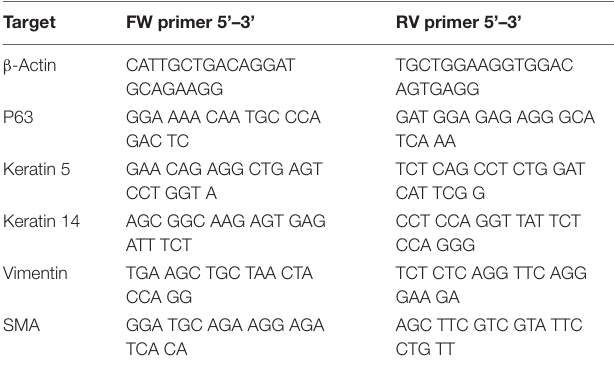
TABLE 1 | Murine primer pairs used for quantitative real time